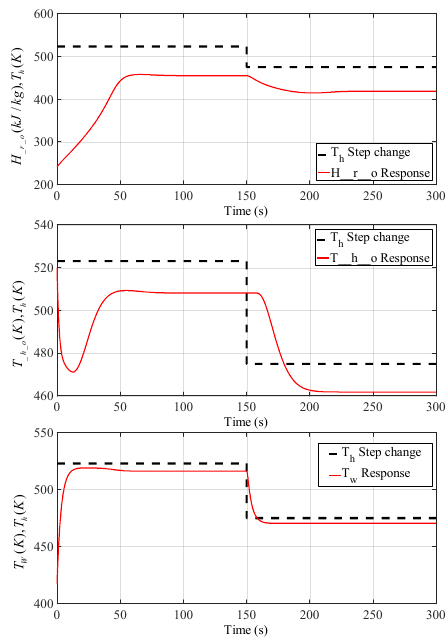
Figure 5. Response of H _ r _ o , T _ h _ o , T W with respect to T h step change.